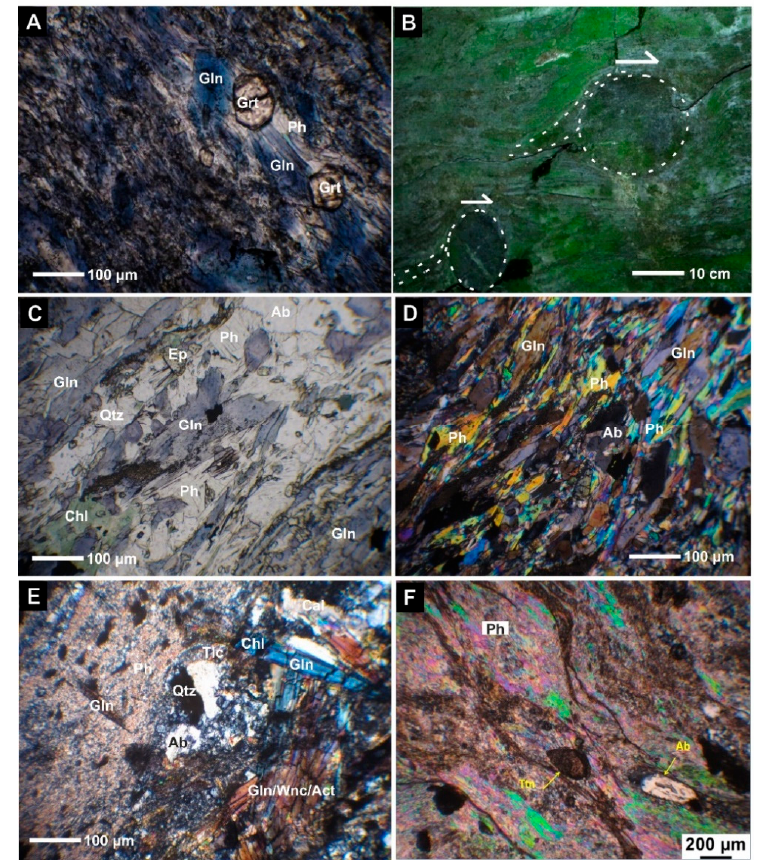
Figure 6. Examples of the Bôrka Unit blueschists: ( A ) metamorphic schistosity of relic D1 bands